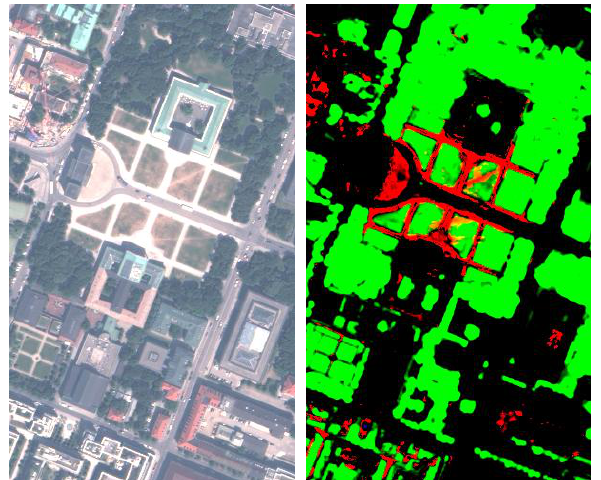
Figure 6. Pan-sharpened first image “K¨onigsplatz”, derived clas- sification (green: vegetation-mask, blue: water-mask, red: soil- mask), 300 m × 500 m each, notice the correctly as water detected